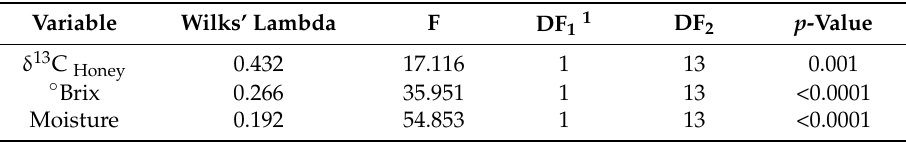
Table 2. Statistical data for variables used in the discriminant